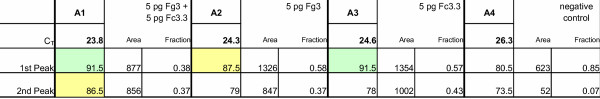
Section of the interpretation sheet corresponding to 4 wells. Each result consists of a well position, sample identifier, CT value, melting temperatures, areas under the melting curve peaks, and fractions of these areas in relation to the total area under the melting curve. The melting data are calculated for the two products with the highest melting temperatures only. Fields are automatically highlighted in a species-specific manner (green: F. culmorum, yellow: F. graminearum) and a warning is issued by a red coloring of the fields when the peak size does not reach the preset absolute and relative minimal values. In addition, if there is an unexpected third melting-curve maximum at temperatures higher than 80°C (indicating the presence of additional PCR products from F. culmorum or F. graminearum), the corresponding well will be highlighted in orange to indicate that the user should check the raw data.